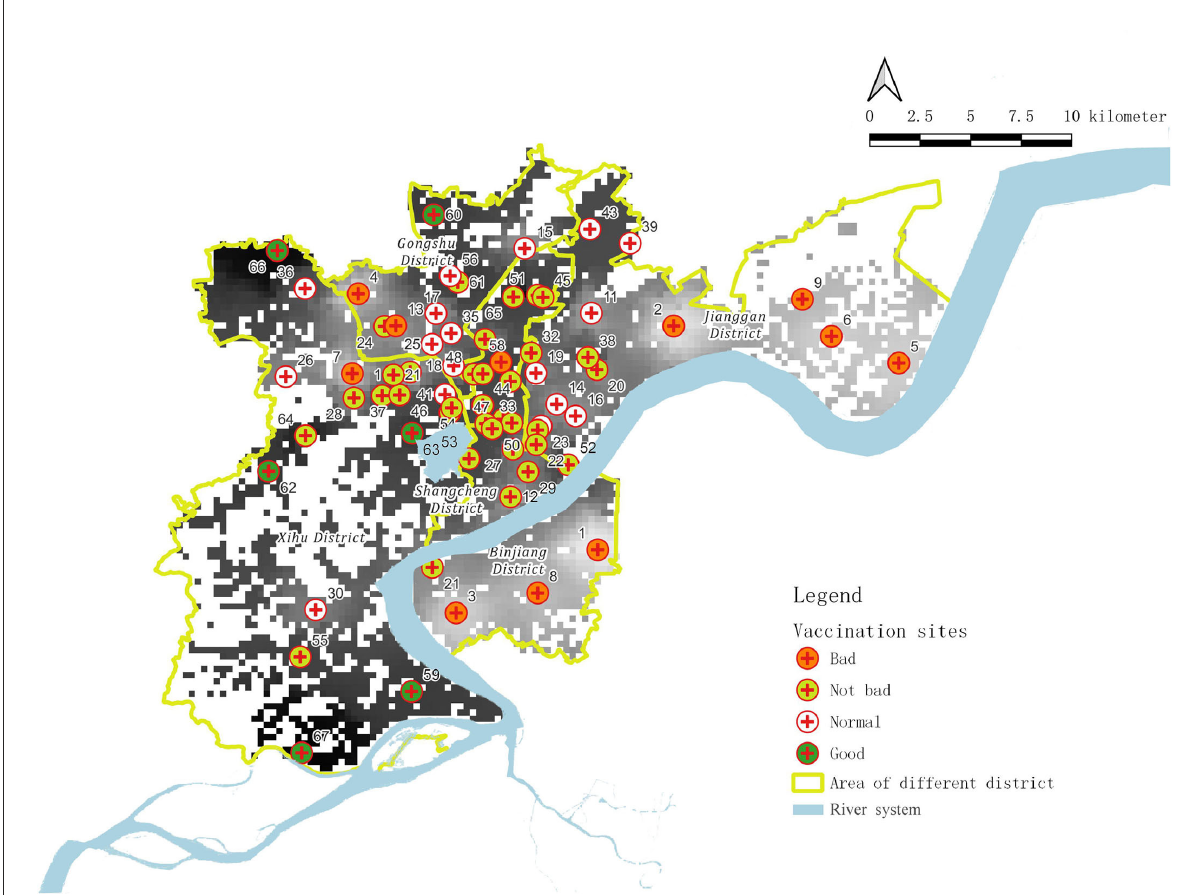
FIGURE4 Analysis chart of medical supply capacity of vaccination